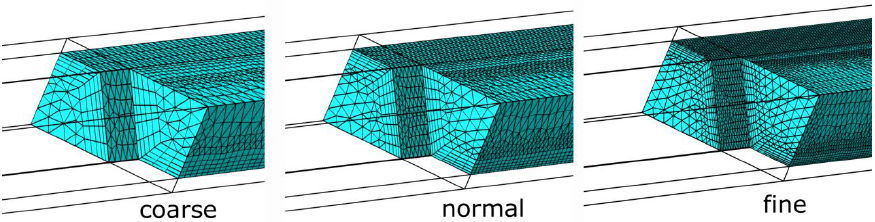
Figure 8. Mesh of the heat exchanger. The normal mesh is used for the parametric analysis.